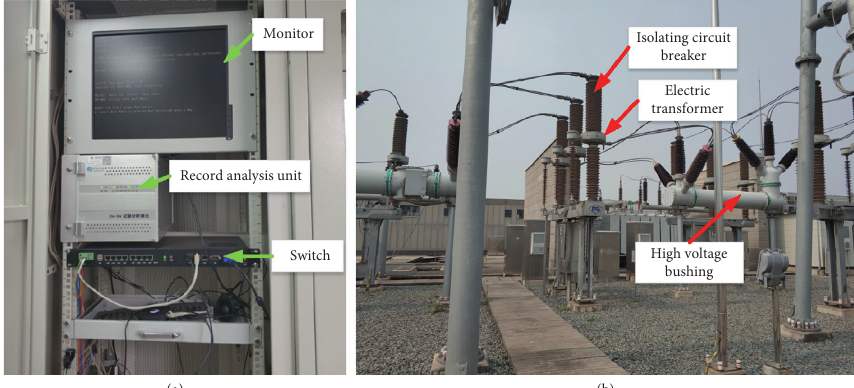
Figure 2: ET metering error condition monitoring platform (a) and ET in the transformer substation (b).